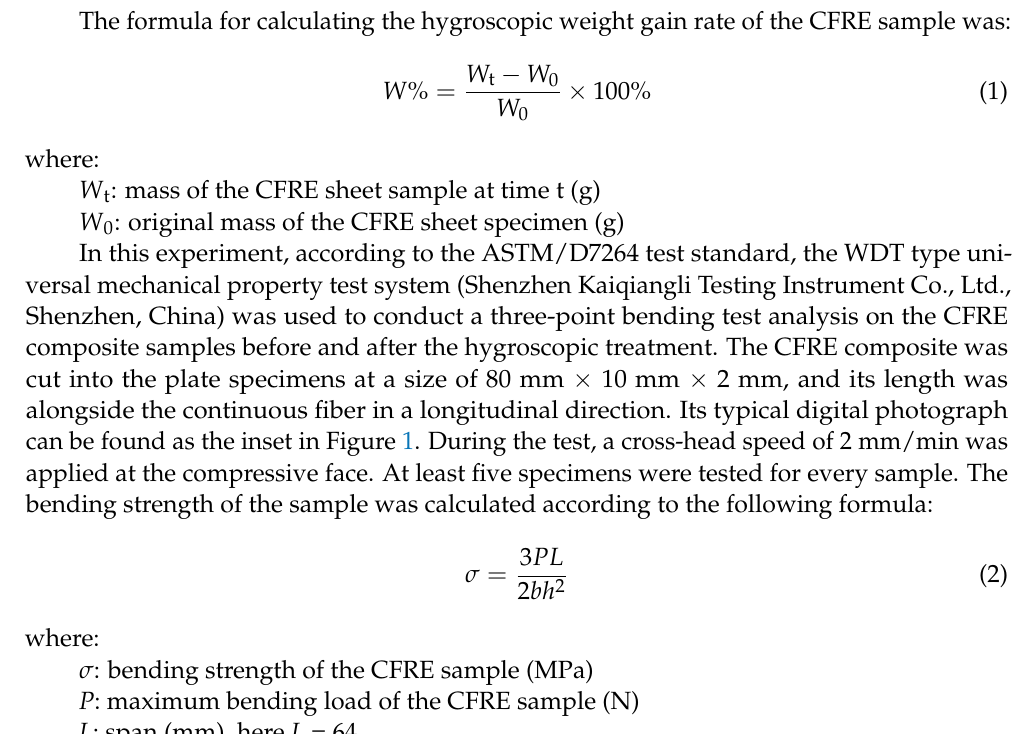
Figure 3. ( a ) the oven and ( b ) the electric balance for the hygroscopic test.